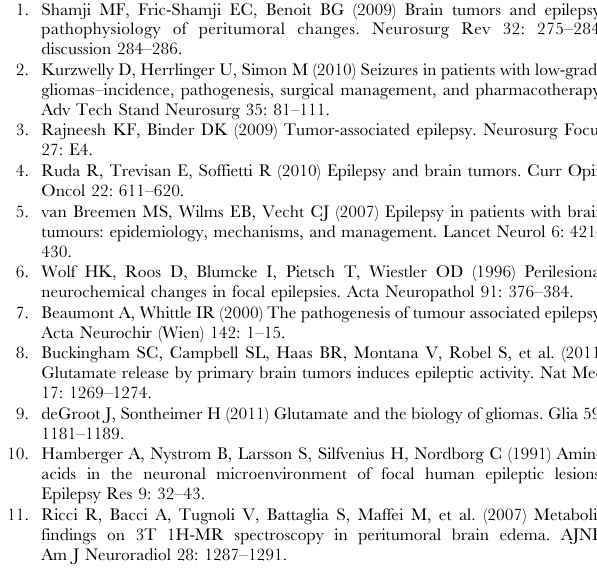
Table S1 Differentially expressed genes of peirtumoral tissues between epilepsy and non-epilepsy. *Student T- test, (no FDR applies), FC $ 6 2 plus P # 0.05. Table S2 RankProd identified DEGs of peirtumoral tissues between epilepsy and non-epilepsy. *Non-para- metric Rank Product approach, the Boconductor RankProd with a FDR= 0.3 applied to identify the